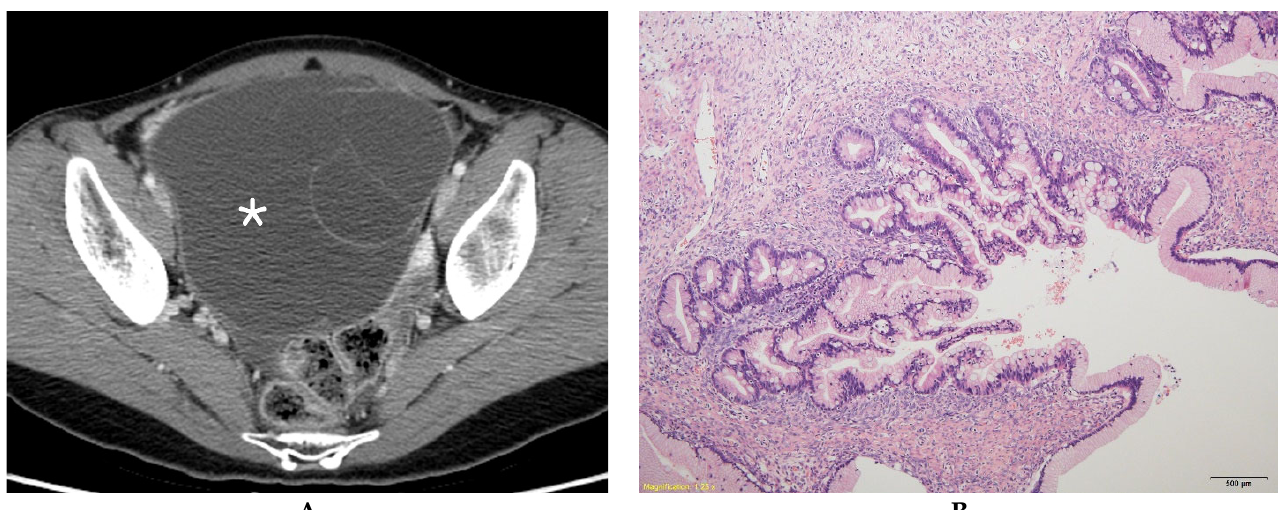
Figure 1. Mucinous borderline ovarian tumor in a 31-year-old woman. ( A ) Contrast-enhanced axial CT shows a multilocular cystic mass (*) without a solid component in the right ovary. ( B ) A histologic section shows aggregates of small loculi covered by a complex mucinous epithelium with a villous architecture (hematoxylin and eosin 100×).